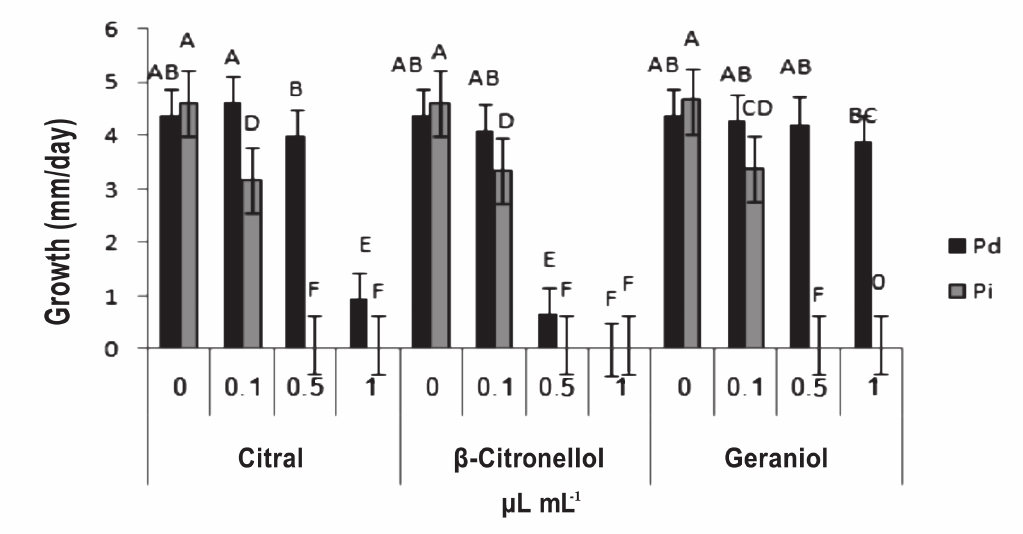
Figure 1. Penicillium italicum (Pi) and P. digitatum (Pd) grown on agar plates amended with different essential oils (contact effect). Bars not followed by the same letter are not signi fi cantly different ( P ≤ 0.01%), Duncan’s Multiple Range Test.